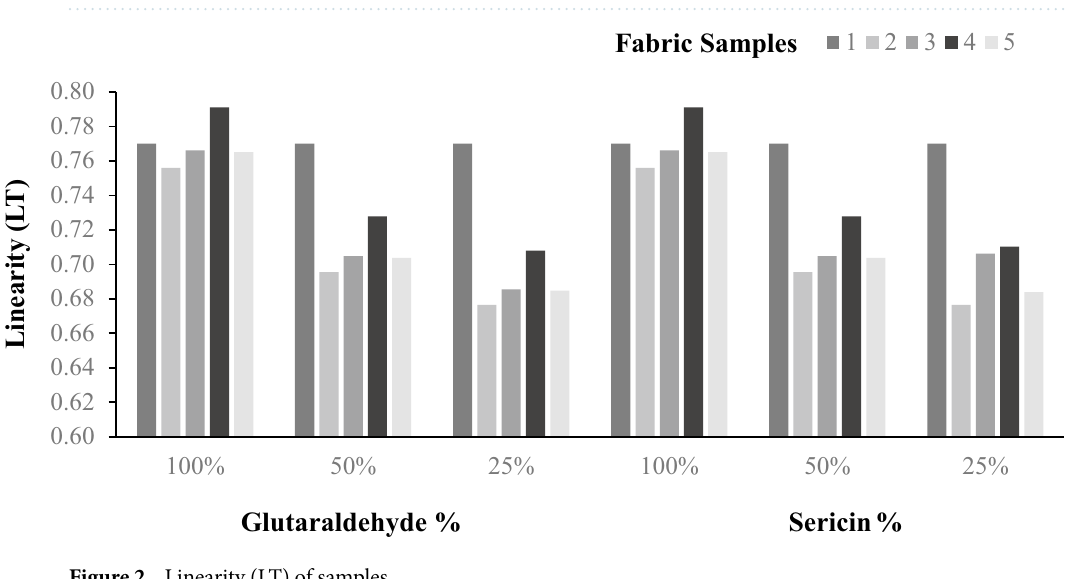
Figure 2. Linearity (LT) of